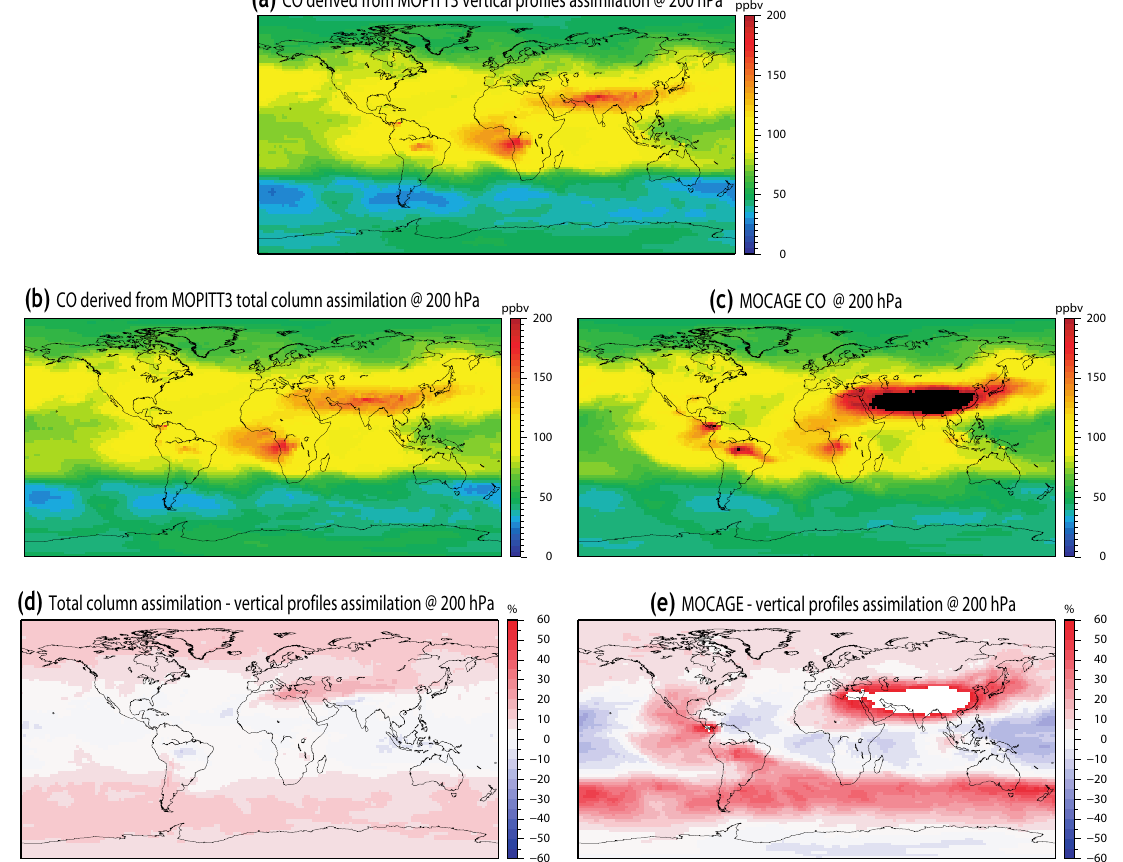
Figure 11. Same as Fig. 10 but for the pressure level Fig. 11. Same as Fig. 10 but for the pressure level 200 hPa .